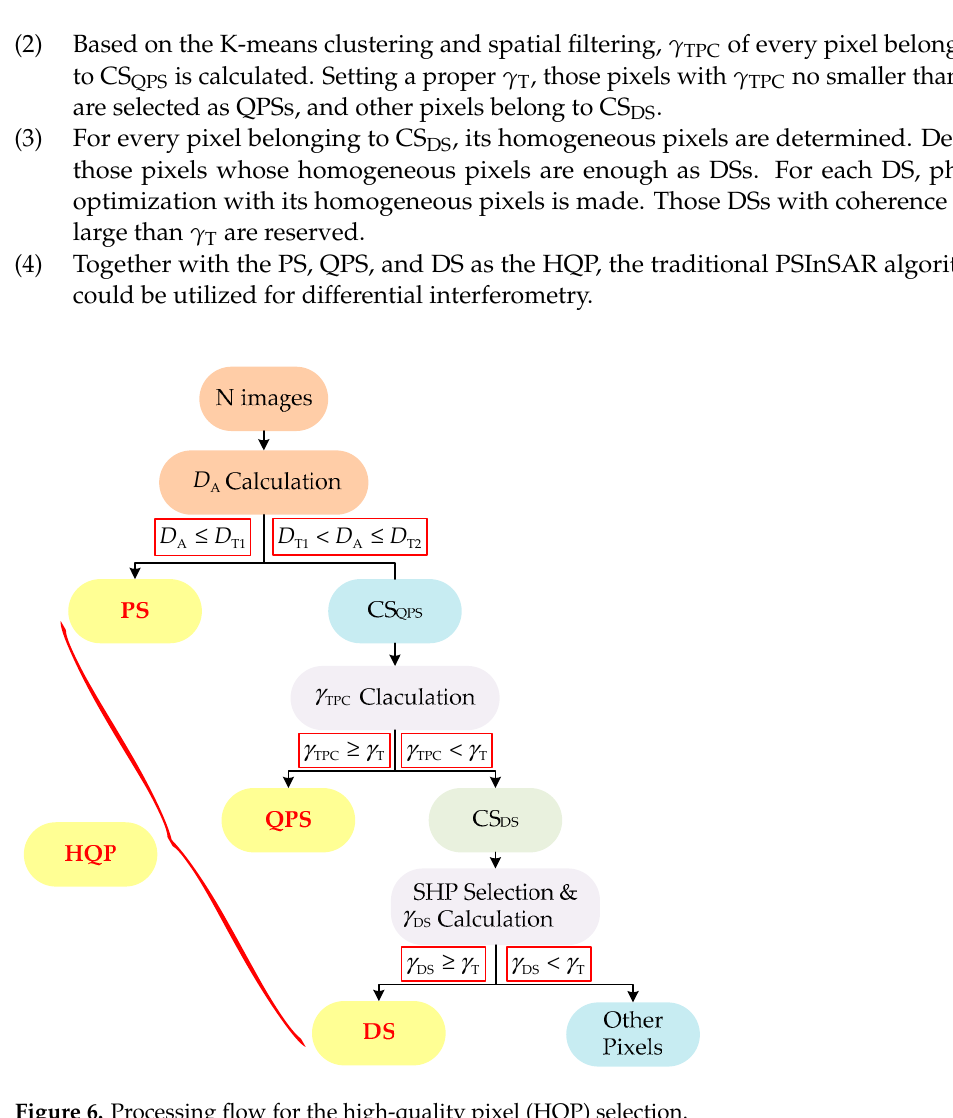
Figure 7. Scene photo.